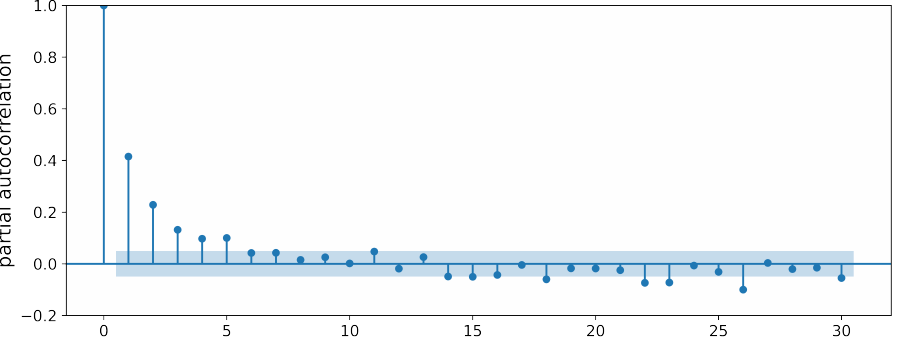
Figure A1. The partial autocorrelation of LSWT. The blue band represents a 95% confidence interval.